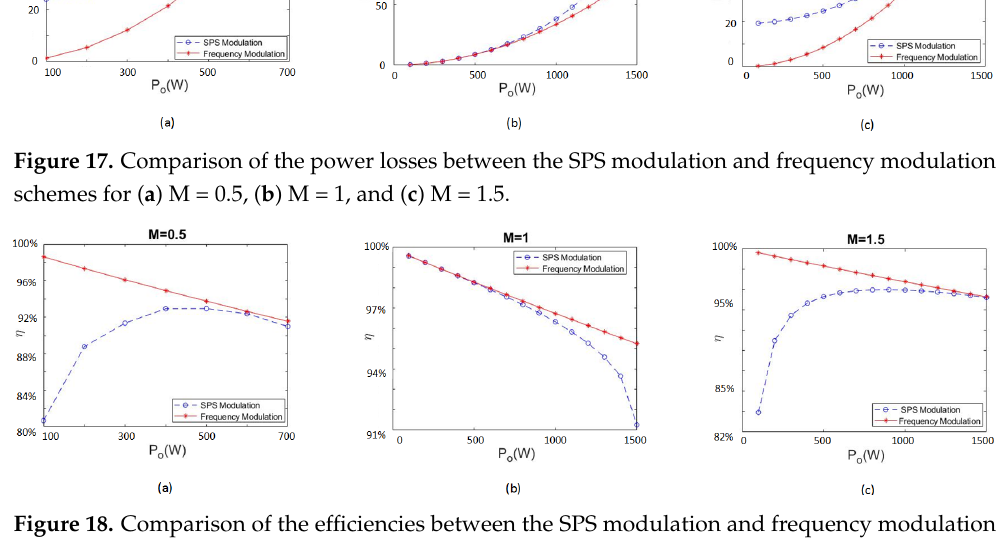
Figure 18. Comparison of the efficiencies between the SPS modulation and frequency modulation schemes for ( a ) M = 0.5, ( b ) M = 1, and ( c ) M =